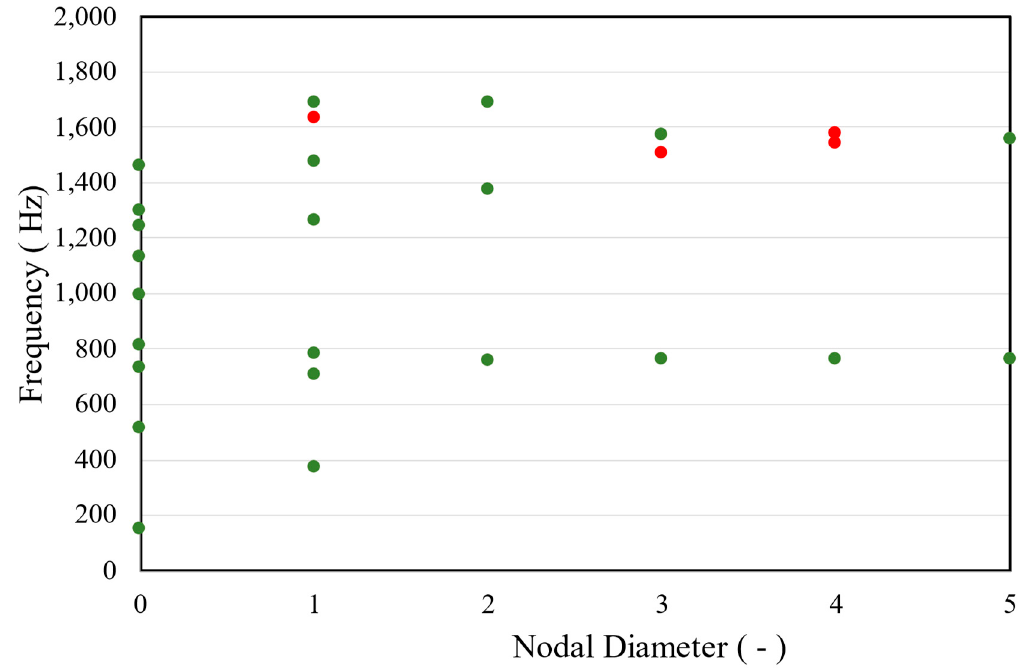
Figure 26. The SAFE diagram of the first-stage moving blade.